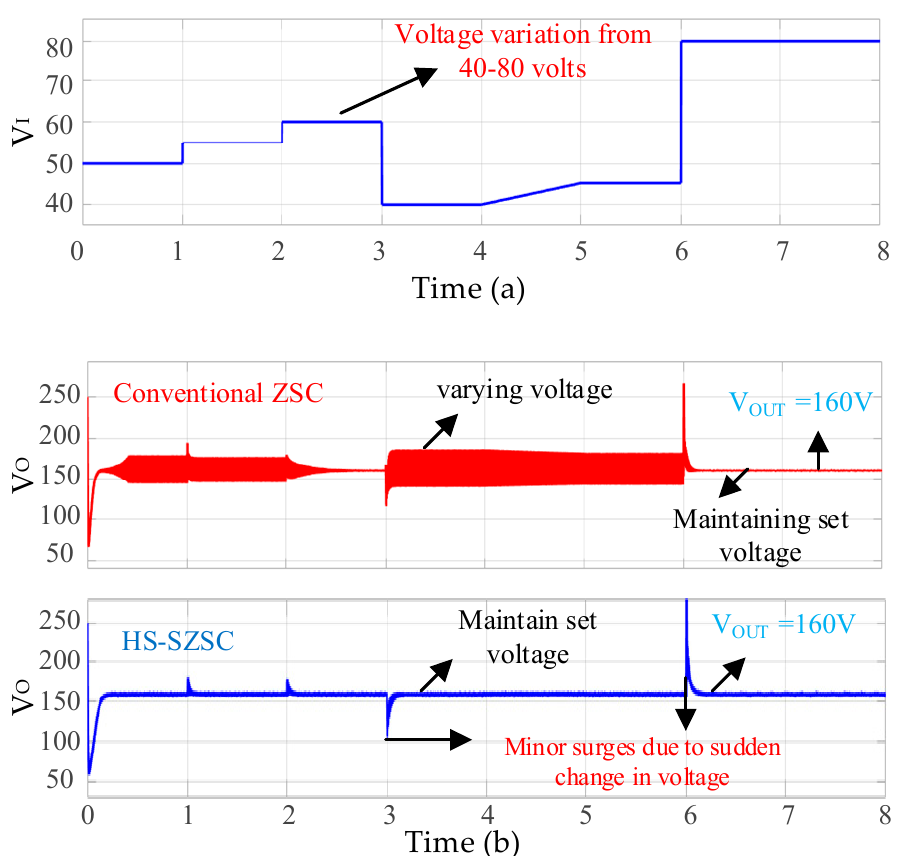
Figure 13. ( a ) The variable input voltage for the conventional ZSC and HS-SZSC (variation between 40–80 V), ( b ) the DC output voltage for the conventional ZSC and HS-SZSC.